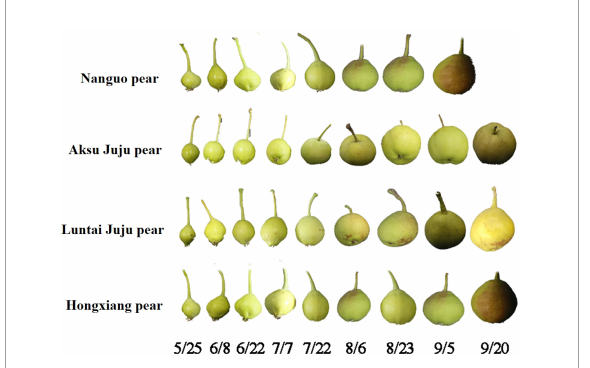
FIGURE1 Fruit at the developmental stage of the Nanguo pear, Aksu Juju pear, Hongxiang pear and Luntai Juju